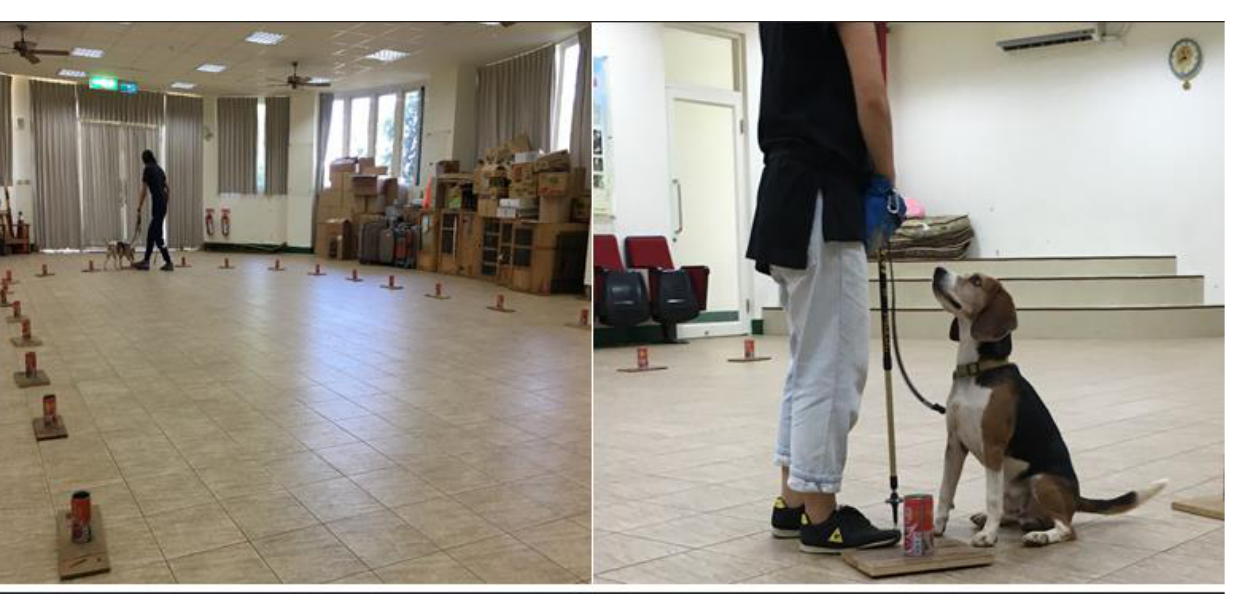
Figure 1. Dogs training. The target was randomly placed in a jar, and the dog leader brought the dog forward for detection. If there was a reaction to the target, a positive response was recorded; otherwise, a negative response was recorded. Response to non-targets was recorded as a false positive. Dogs were trained to sit down as a reaction and given a food reward if the reaction was positive.